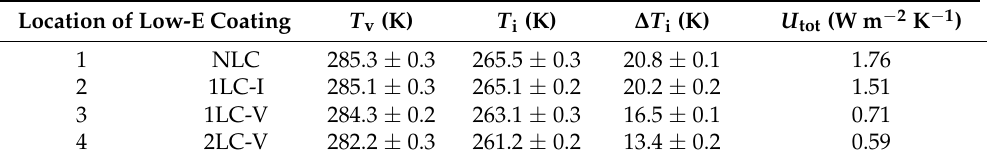
Table 6. Simulation results of the surface temperature and heat transfer coefficient of CVG with different positions of the Low-E